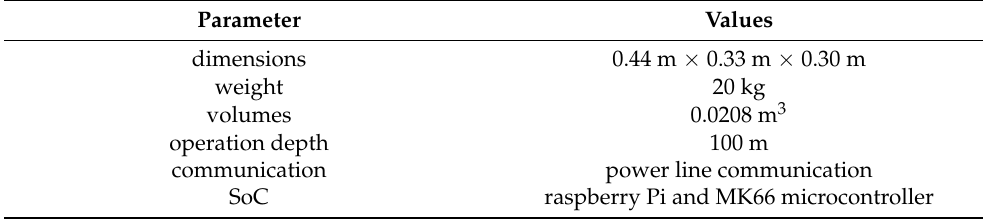
Table 2. Nominal parameters of the “Lingrui” ROV.